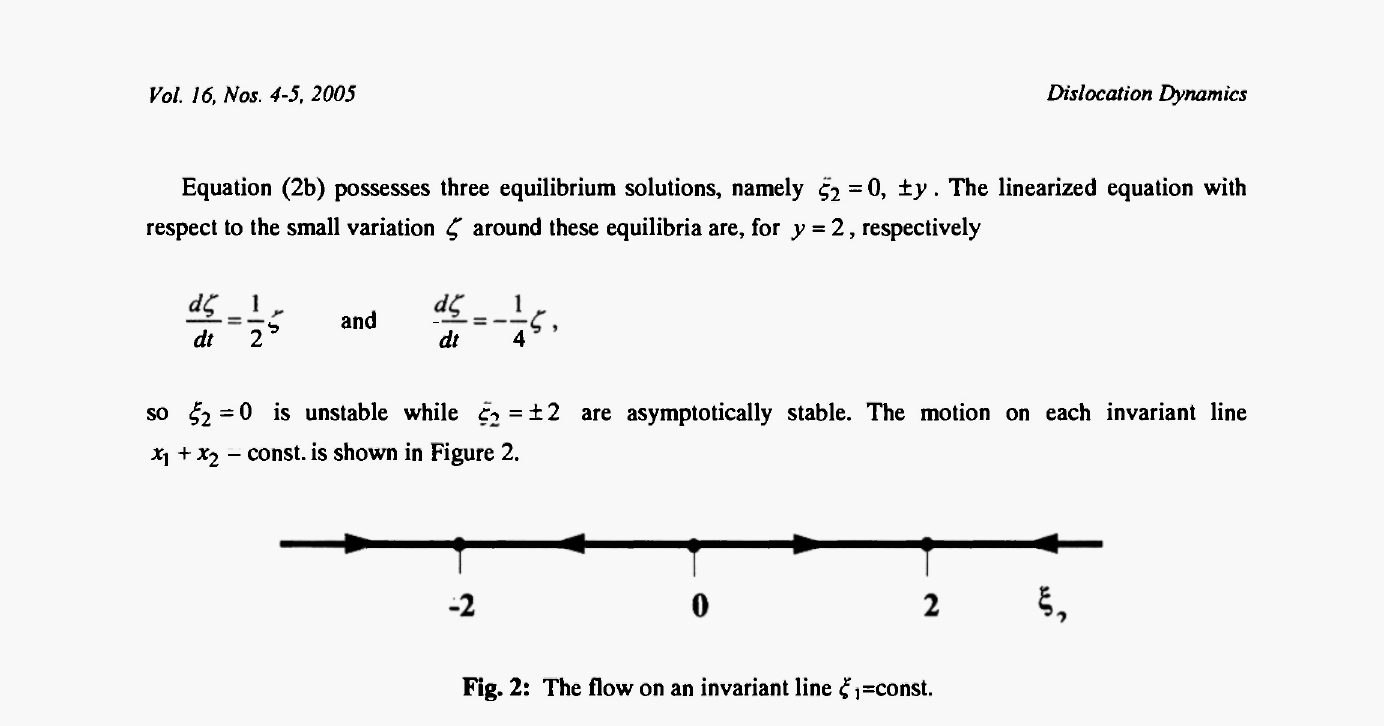
Fig. 2: The flow on an invariant line ξ ]=const.